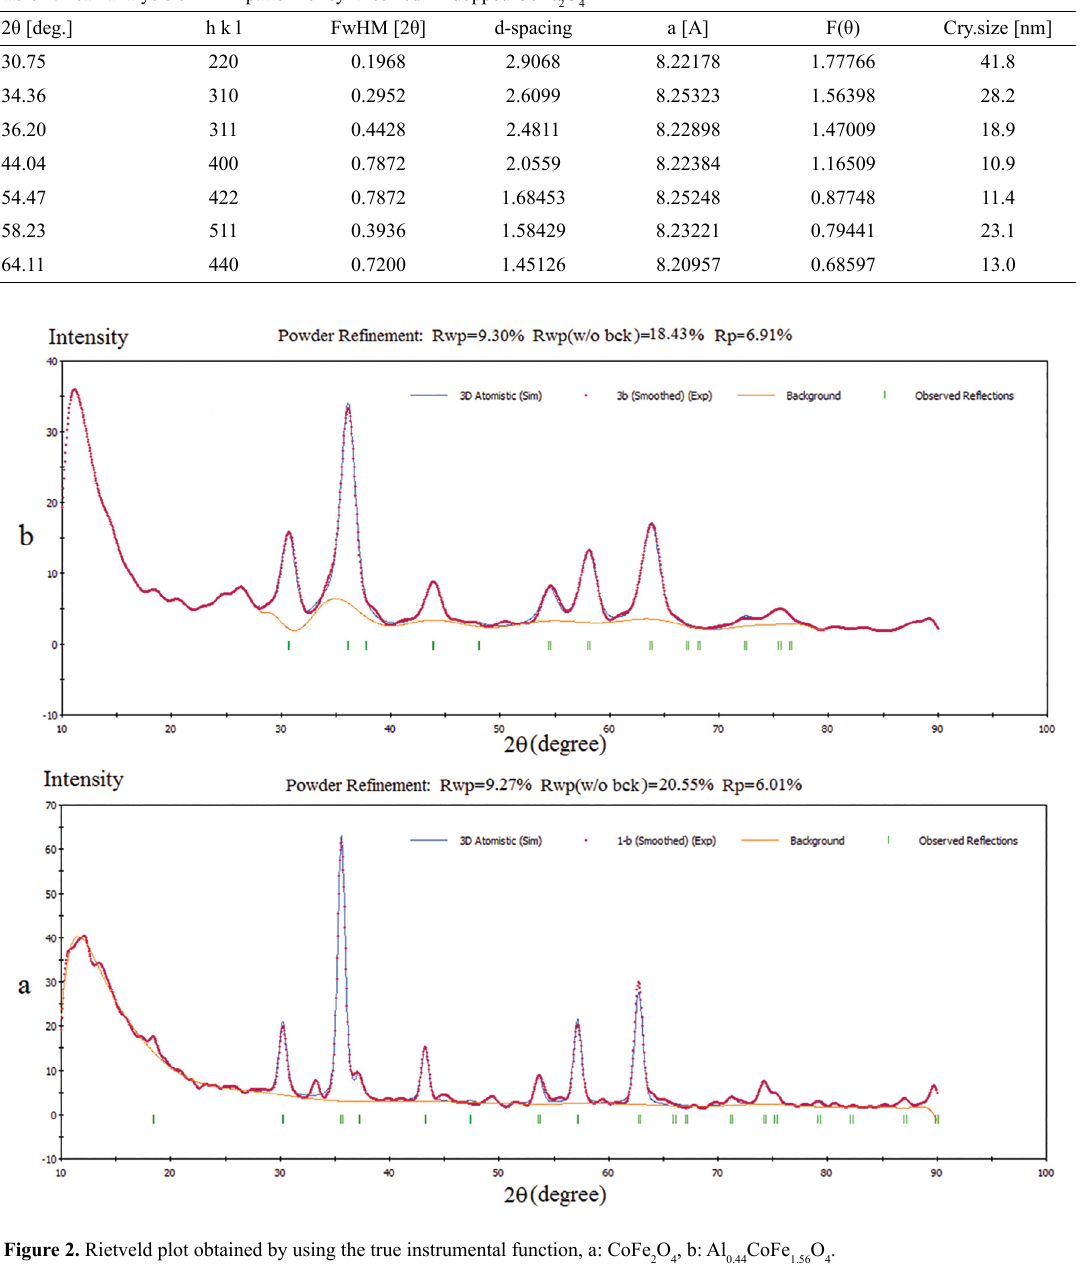
Figure 2. Rietveld plot obtained by using the true instrumental function, a: CoFe